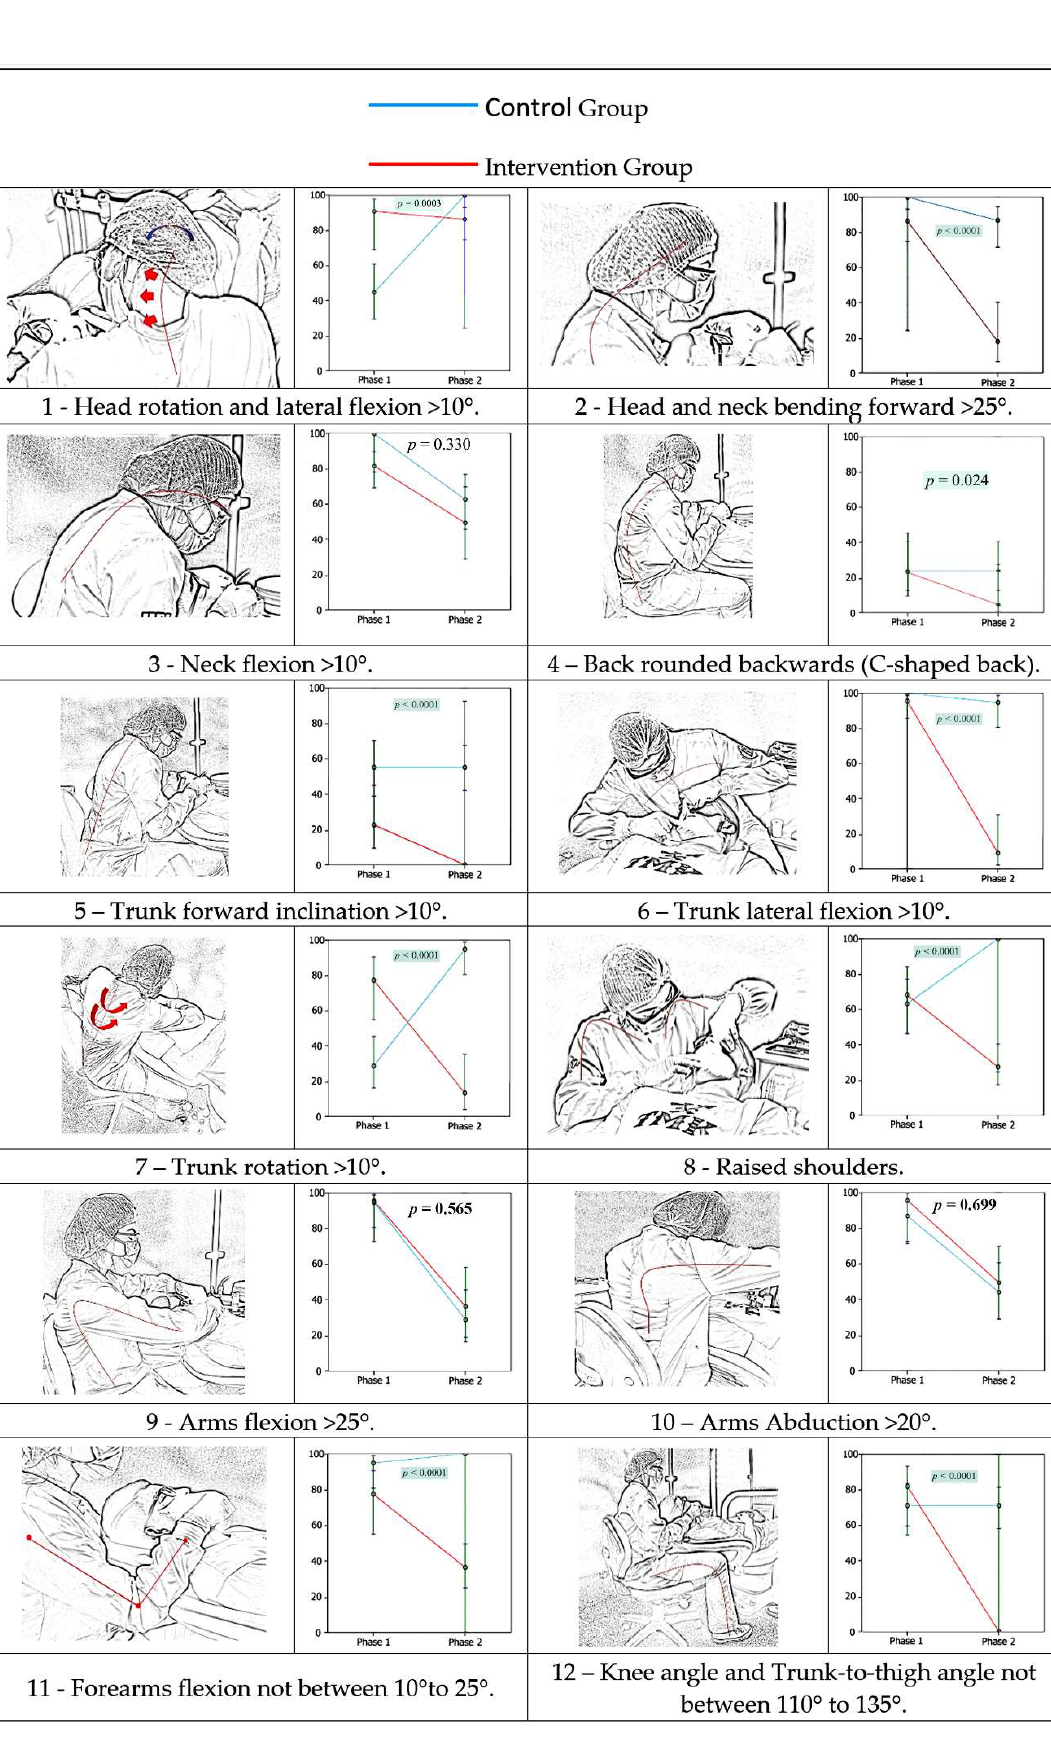
Figure 6. ( 1 – 12 ) Comparison of the awkward posture prevalence between groups and phases, according to 12 accessed parameters.